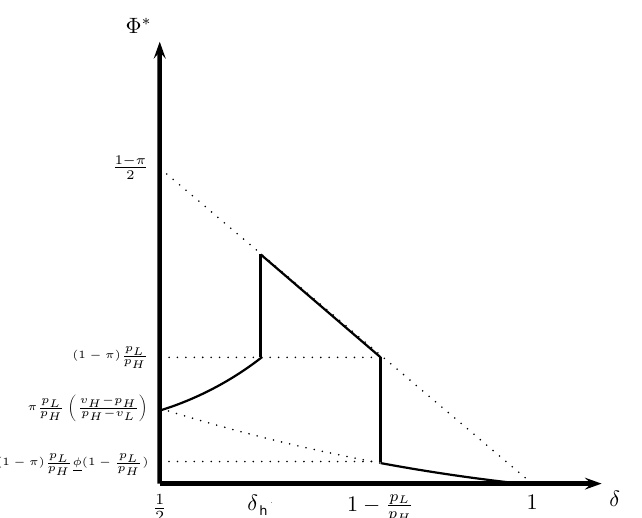
Figure 3. The equilibrium incidence of fraud as a function the signal precision δ if p H > max ( p L / p H ) and δ h < 1 −